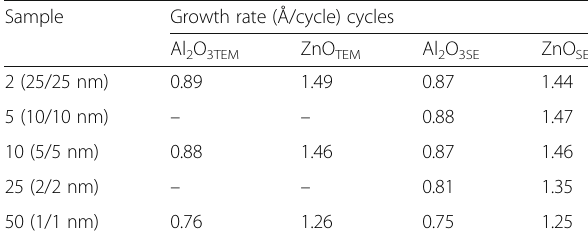
Table 3 The growth rates of samples with different bilayer thicknesses